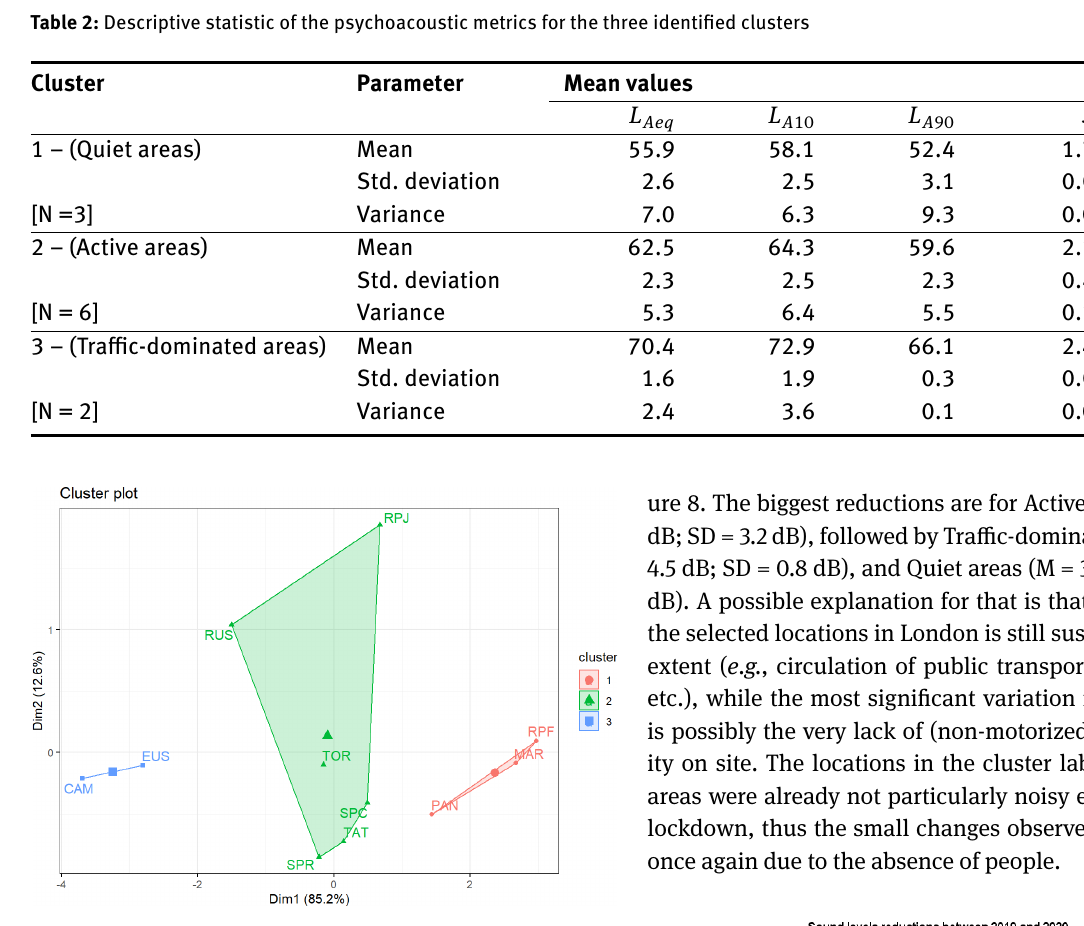
Figure 7: Bi-dimensional plot for the three-cluster solution (loca- tions labels as per in Table 1). The clusters have been labelled as: Cluster 1 – Quiet Areas; Cluster 2 – Active areas; Cluster 3 – Traflc-